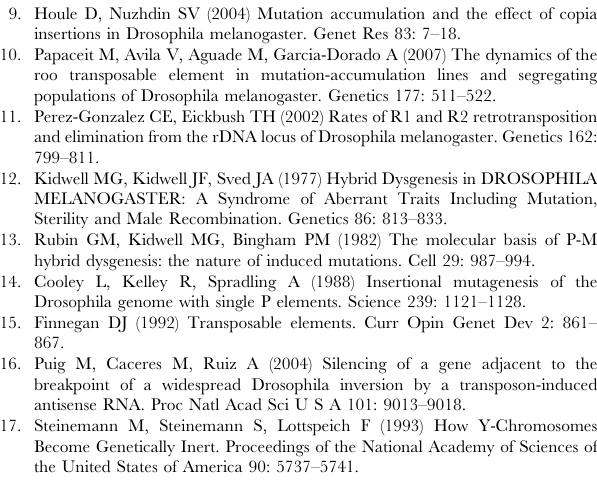
Figure S1 Distribution of TE insertions and their population frequencies in D. melanogaster . The x-axis shows the position in the chromosome and y-axis the population frequency of a TE insertion. Light grey insertions indicate low recombining regions